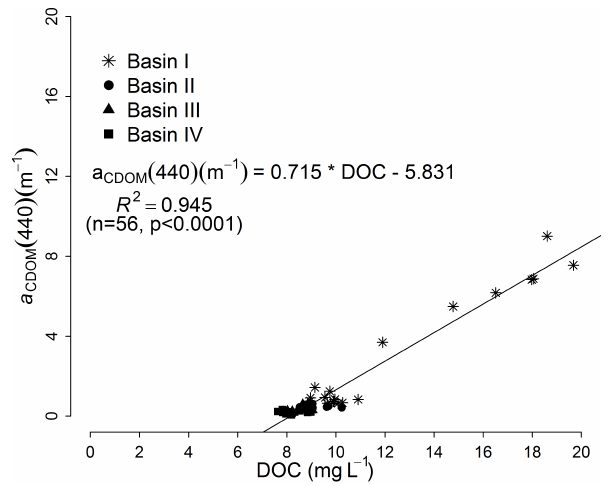
Figure 8. Scatter plot of a CDOM (440) plotted as a function of DOC concentration (mgL − 1 ). Line is a regression curve by least squares